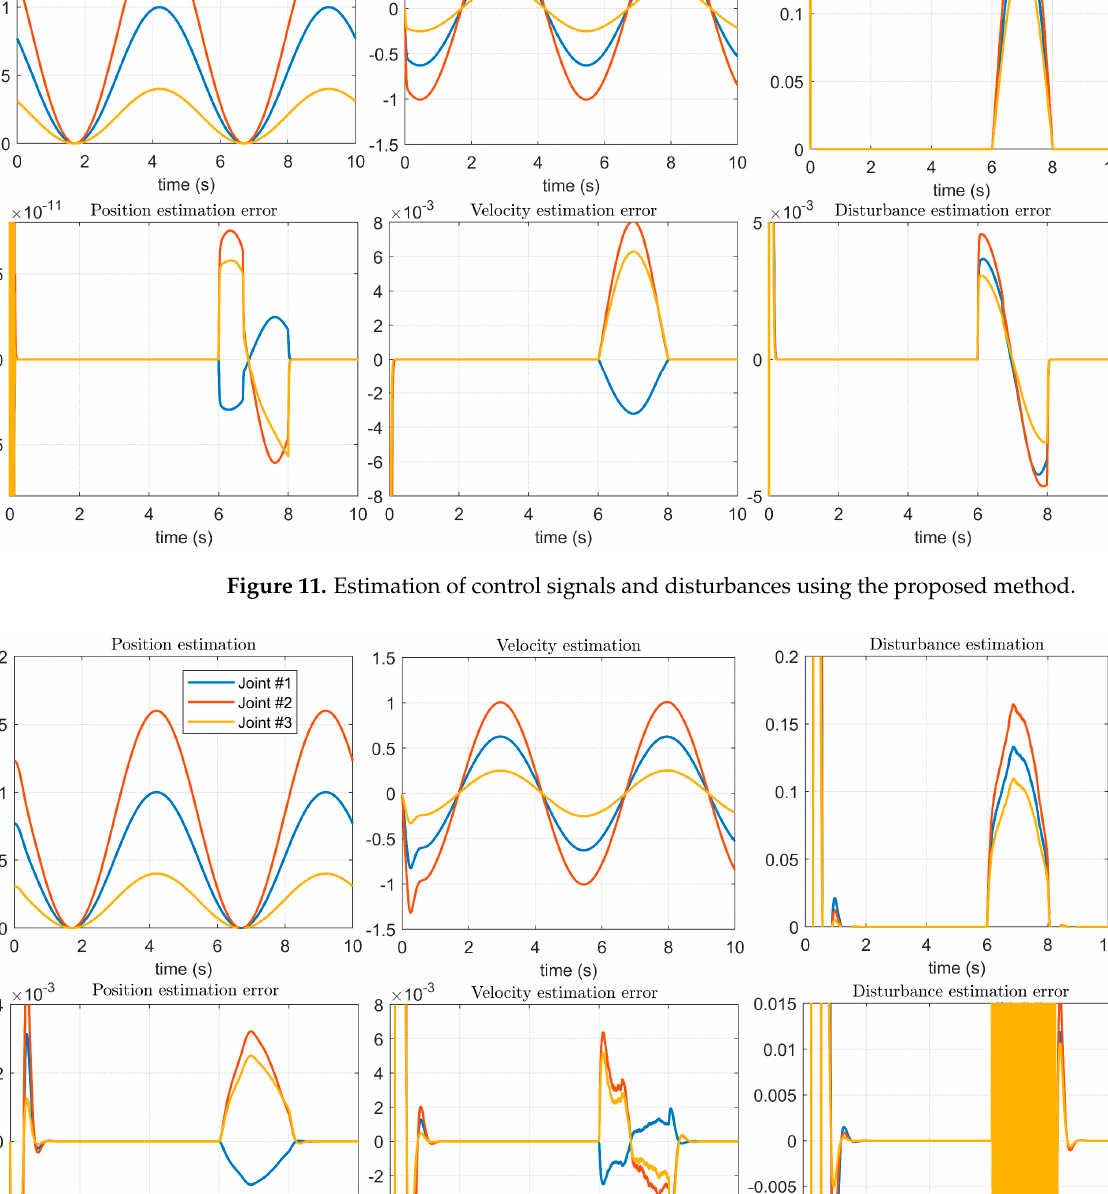
Figure 12. Estimation of control signals and disturbances with noise using the method in [14].